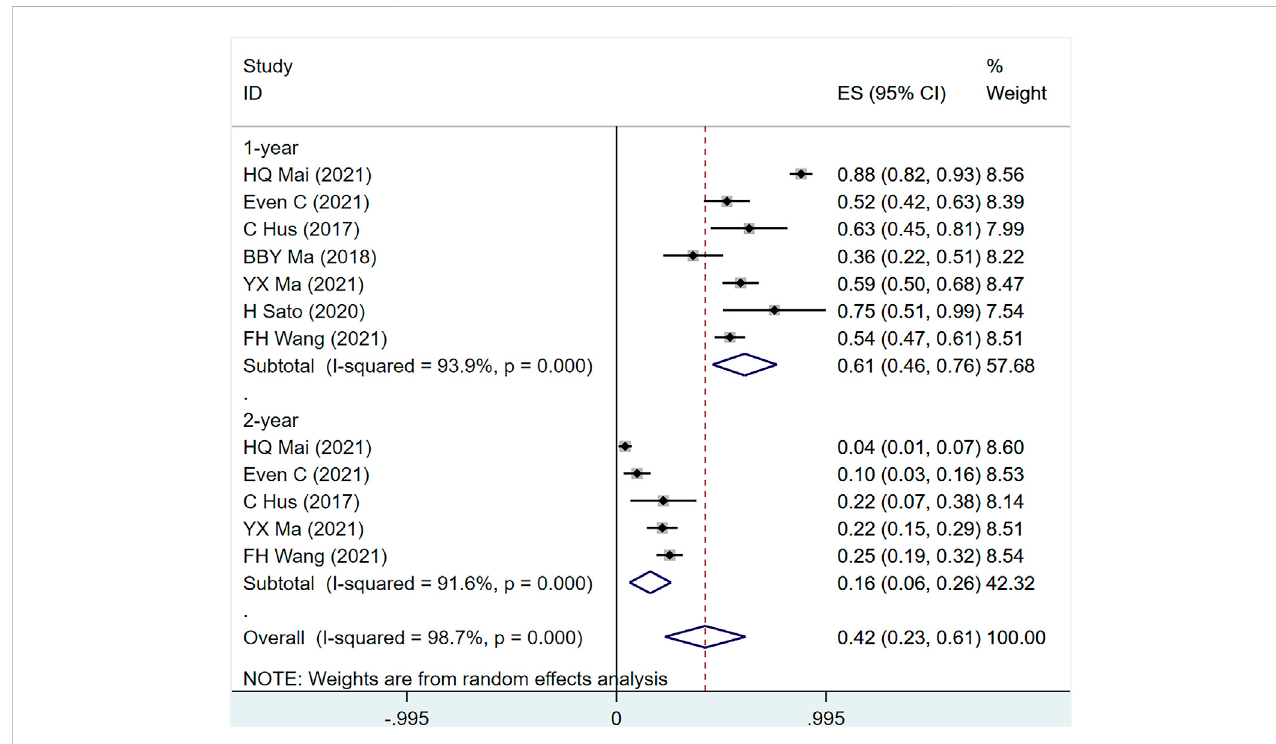
FIGURE 6 Estimated OS proportion (95% CI) of patients with metastatic/recurrent nasopharyngeal carcinoma after PD-1 treatment forest plot — single arm